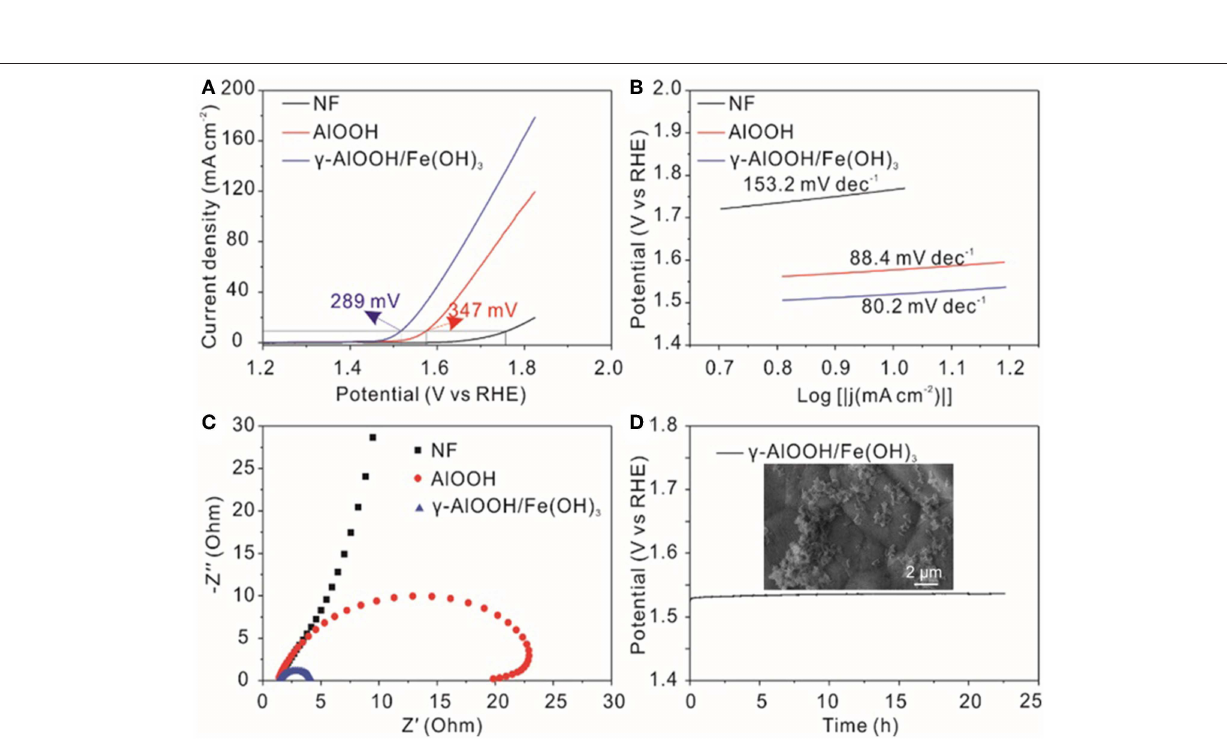
Frontiers in Materials | www.frontiersin.org